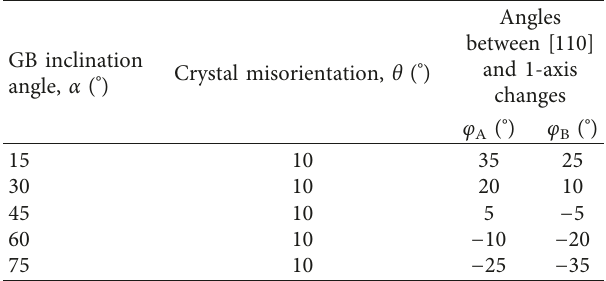
Figure 12: Mises stress scale factors on the boundary for type II Table 2: Angles between [110] orientation and 1-axis changes with different GB inclination angles.